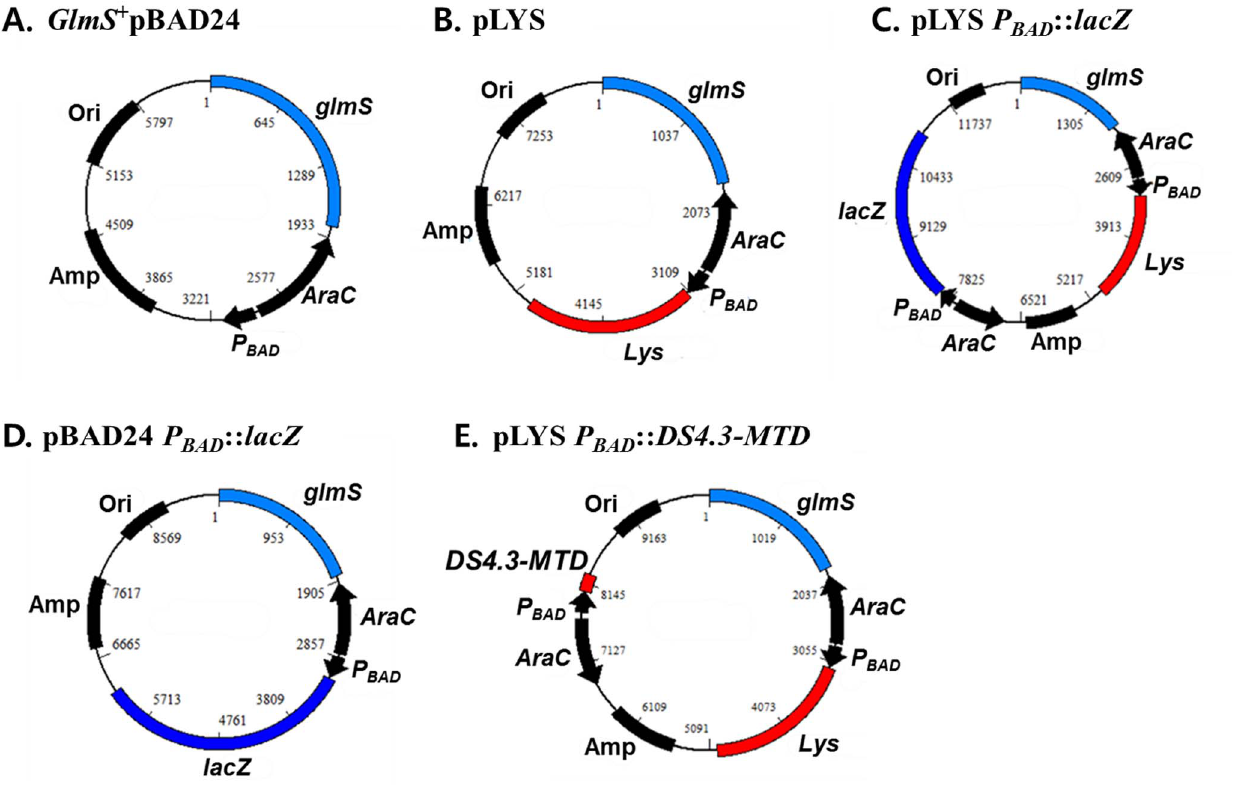
Figure 1. Schematic diagram of the plasmids used in this study. ‘Lys’ carried the locus with Salmoella lysis function of the phage iEPS5 phage.